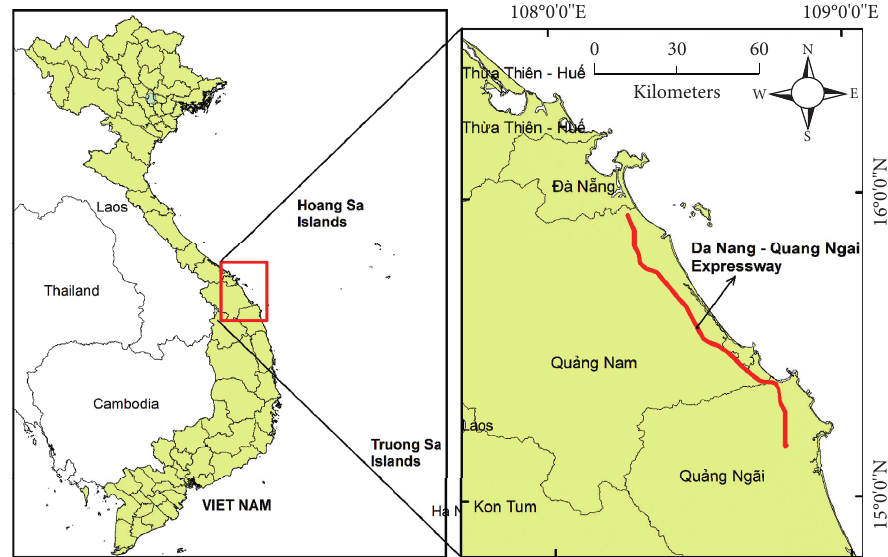
Figure 1: Location of Da Nang-Quang Ngai expressway project,